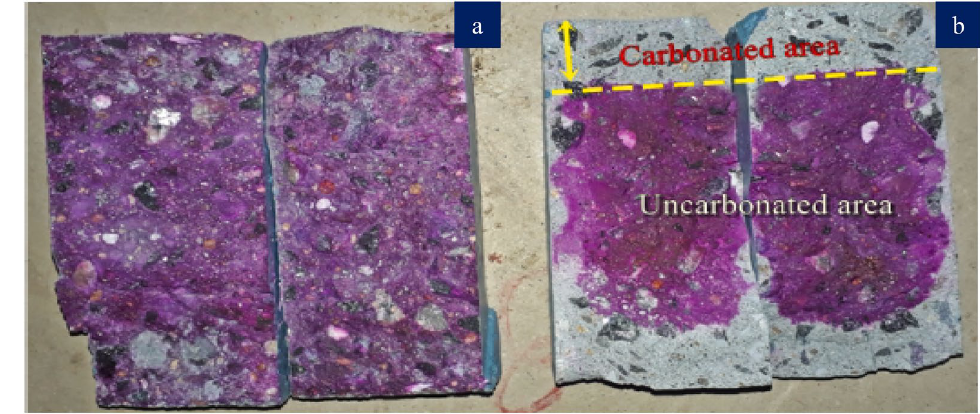
Fig. 17 Minimum and maximum carbonation depth ( a ) reference and ( b ) 35% fly ash and 20% marble (Choudhary et al.,